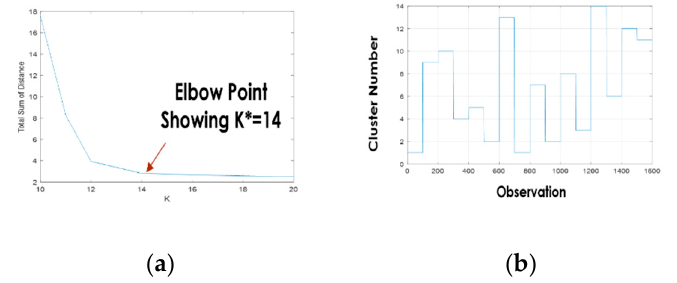
Figure 4. The results of multi-sensor data clustering. ( a ) Total sum of distance ( b ) Cluster number. Table 3. Average Concentration in Each Cluster Determined in Step 1.